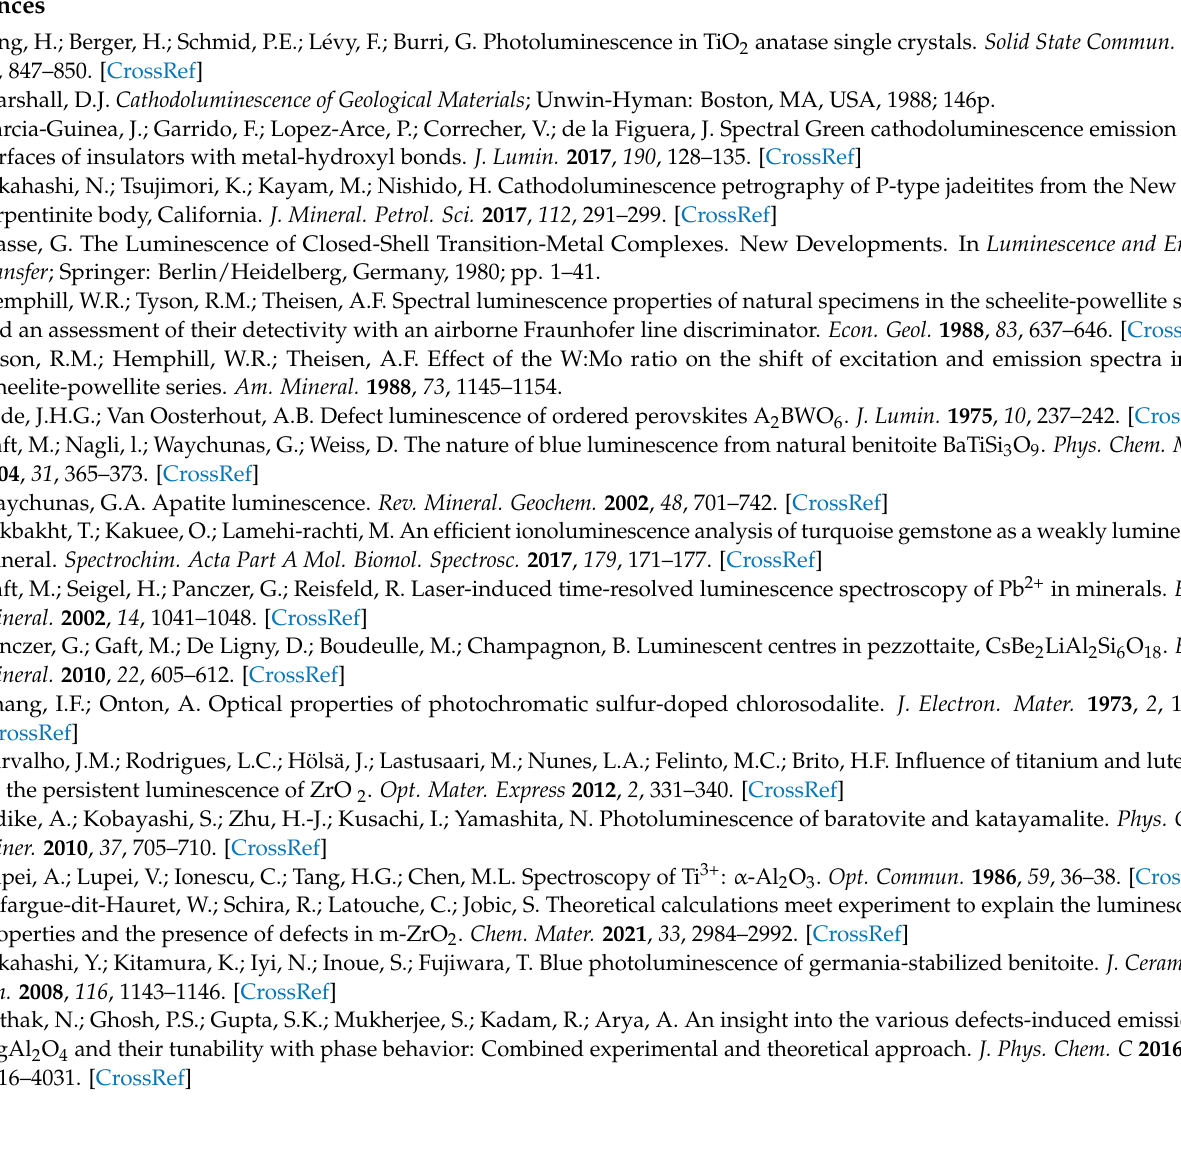
Table S2: Data associated with Figure 5, mineral & formula, Ti-O distance, emission maxima (in nm and eV), bibliographic sources for luminescence and Ti-O distance